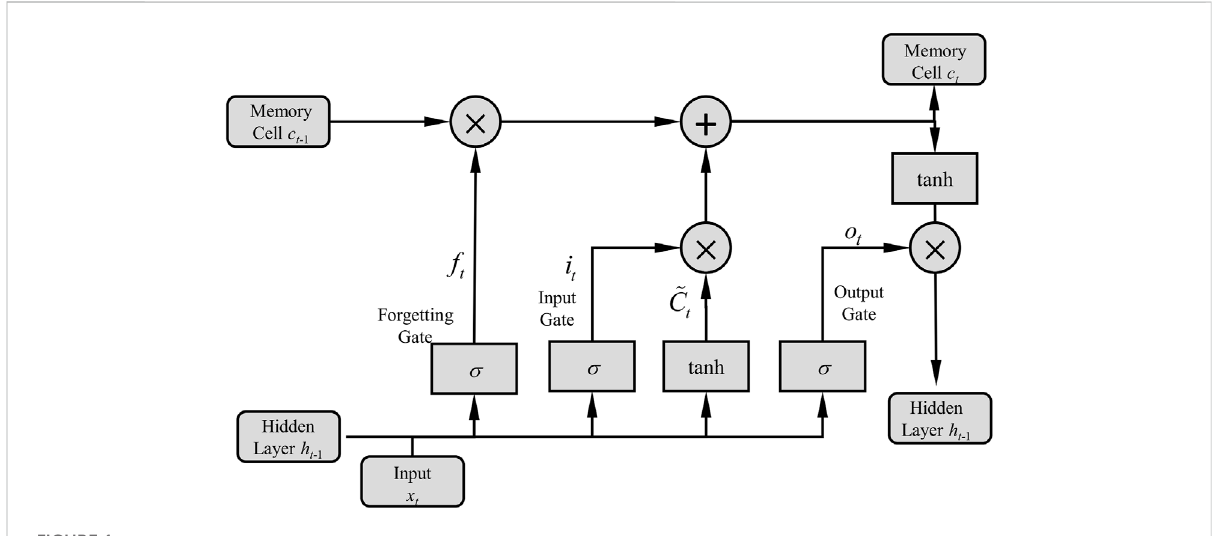
FIGURE 1 Basic structure of LSTM (Bengio et al.,